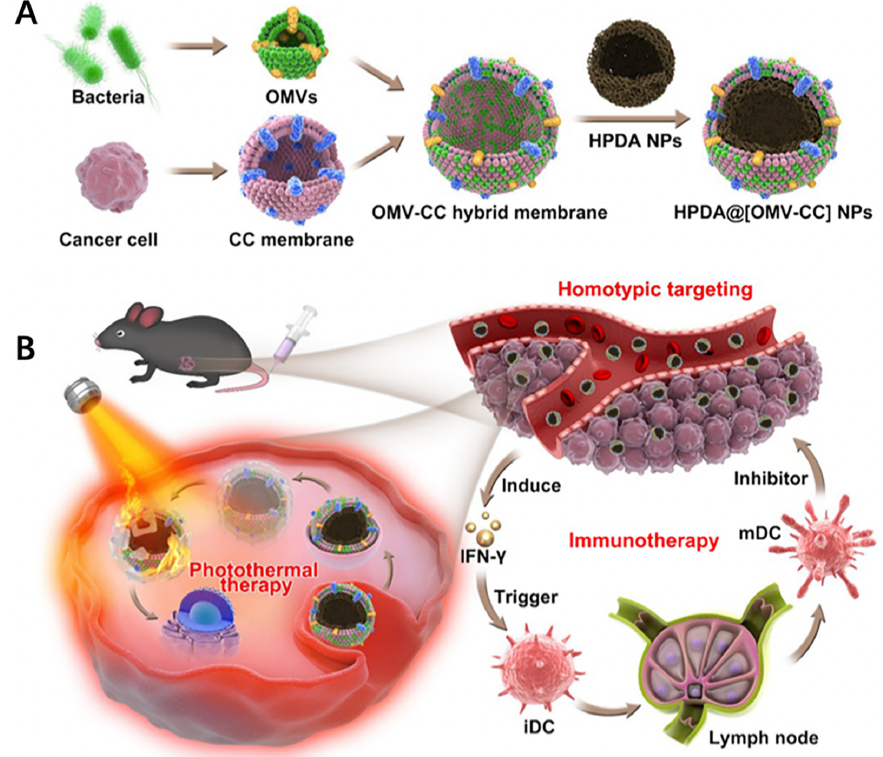
Figure 3. ( A ) Schematic of the membrane derived from OMV and CC fusion and the resulting